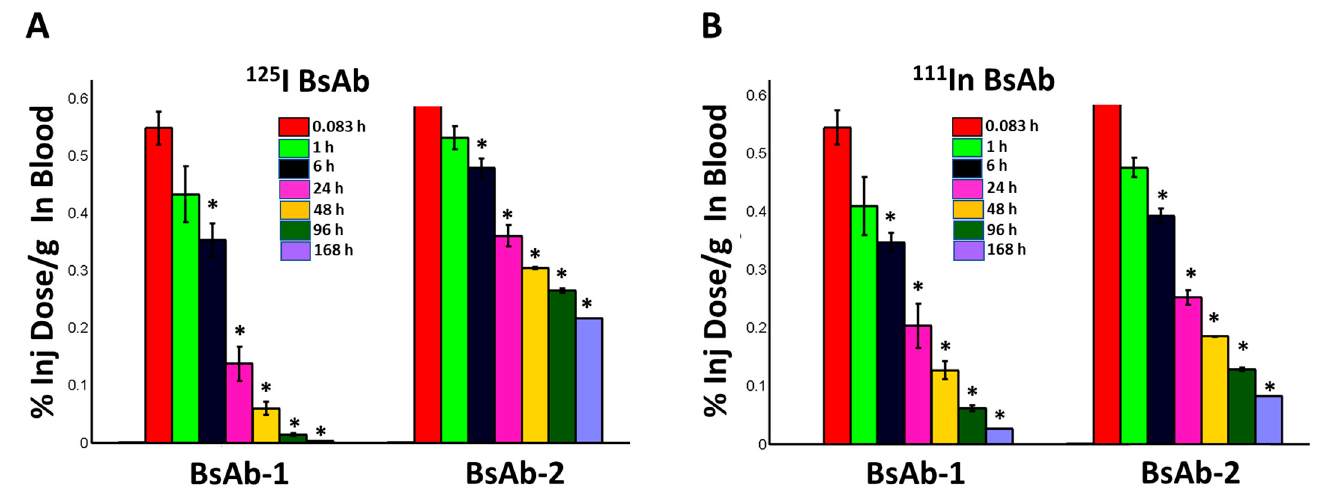
Figure 2. Mean concentrations (%ID/g) of ( A ) 125 I-labeled BsAb-1 and BsAb-2 and ( B ) 111 In- labeled BsAb-1 or BsAb-2 in male cynomolgus monkeys following a single IV administration of ~5 mg/kg (~0.015 mCi total 125 I- and 111 In- labeled BsAb-1 or BsAb-2 mixed in equal amounts) in blood. Blood data are the mean (+/ − standard deviation or SD) for n =3 timepoint for each molecule at 0083, 1, 6, 24 and 48 hours post administration for each isotope; n = 2 timepoint (+/ − SD) for each molecule at 96 hours post administration for each isotope and n = 1/timepoint for each molecule at 168 hours post administration for each isotope. The SD for the n = 2 timepoint is displayed for illustrative purposes only. Statistical comparisons of the concentration versus time data were conducted between the two molecules labeled with the same isotope and between the same timepoint after administration. The * symbol indicates statistically significant ( p value < 0.05) differences between BsAb-1 and BsAb-2 for the same isotope at the same timepoint post administration.